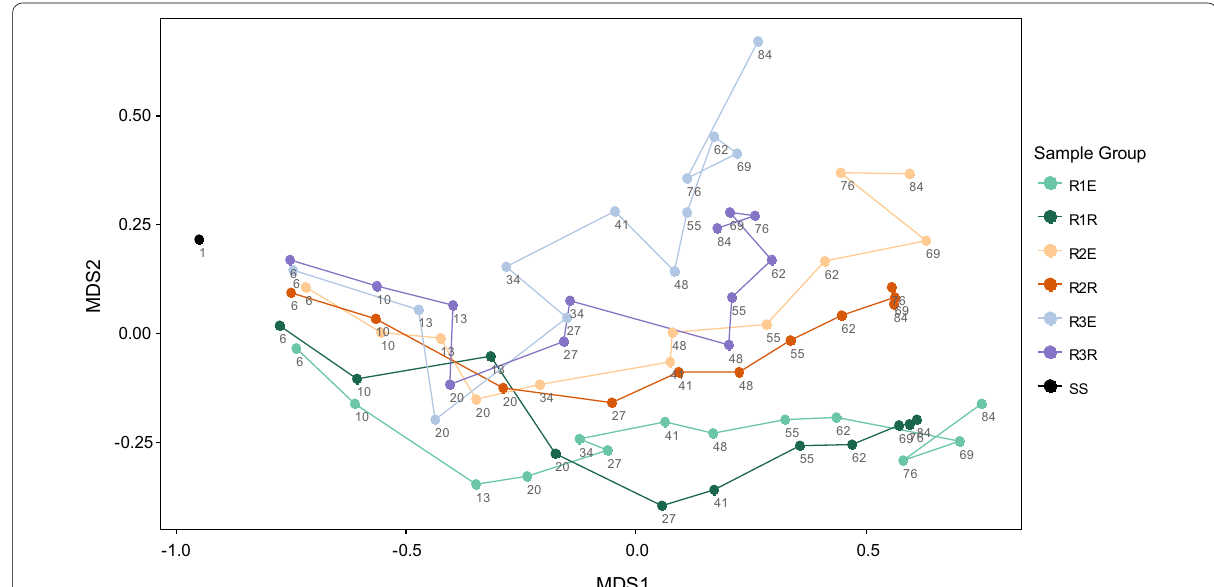
Fig. 1 Non‑metric multidimensional scaling (NMDS) ordination based on Bray–Curtis dissimilarity matrix. Samples are indicated with the number of days since seeding. R1E, R2E, R3E: effluent samples (suspended phase); R1R, R2R, R3R: samples from the reactor content (granular phase), SS seed